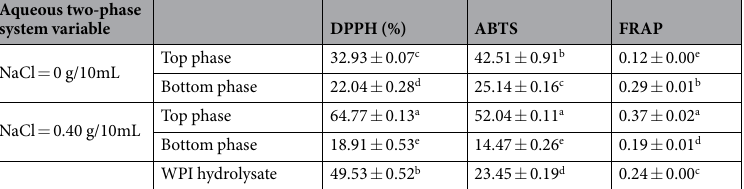
Table 4. Effect of NaCl on the separation of antioxidant peptides. 1 The data (mean ± standard deviation) derived from 3 replicates as described in the Materials and Methods section. 2 The difference between the mean values with the same superscript letter in the same column was significant at a 95% confidence interval.